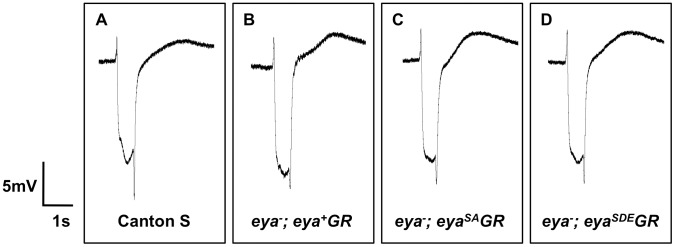
Animals rescued with eya*GR have normal eye function.Representative ERG traces of Canton S (wild-type) (A), eyacliIID/Df; eya+GR/+ (B), eyacliIID/Df; eyaSAGR/+ (C), and eyacliIID/Df; eyaSDEGR/+ (D) adults. eya null adults rescued with a single copy of eyaSAGR or eyaSDEGR show ERG responses indistinguishable from flies rescued with eya+GR or wild-type flies.